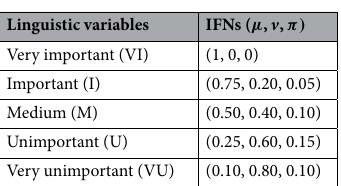
Table 2. Linguistic variables for evaluating each criterion 53 .